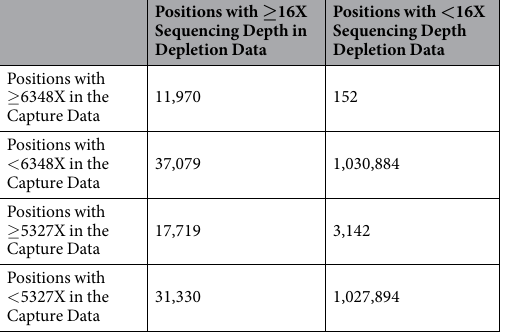
Table 2. Wolbachia Sequencing Depth Threshold